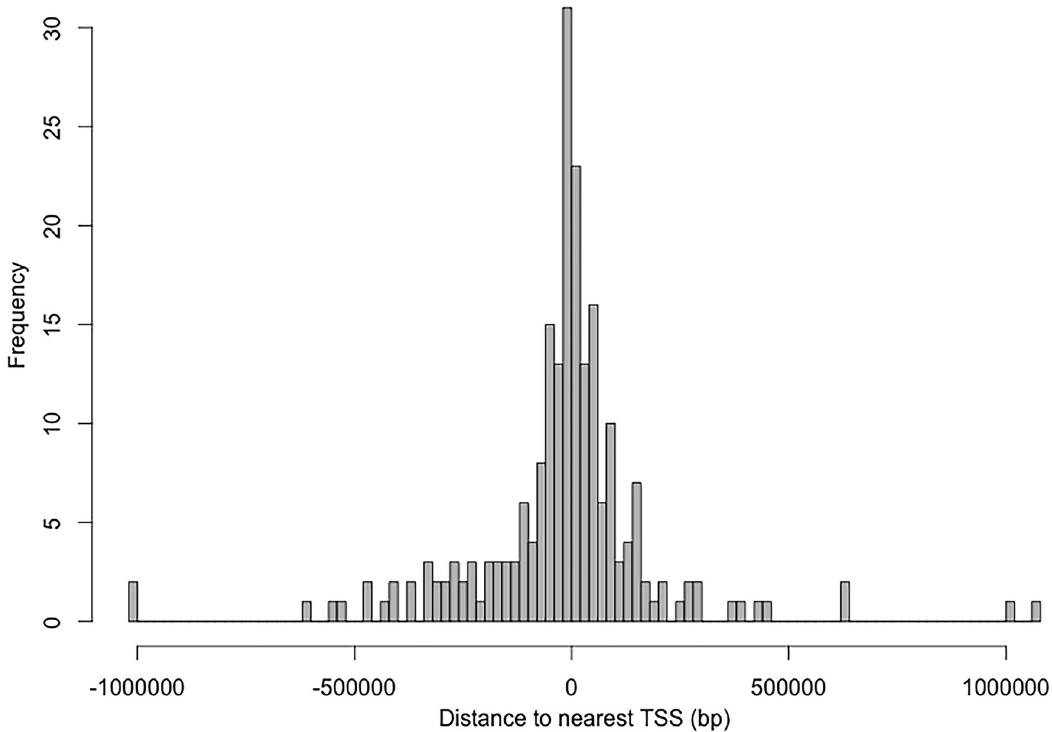
Fig 7. Frequency of DMRs’ distance to closest transcription start site. The distance from the transcription start site is represented in base pairs from the 0 in the x axis.